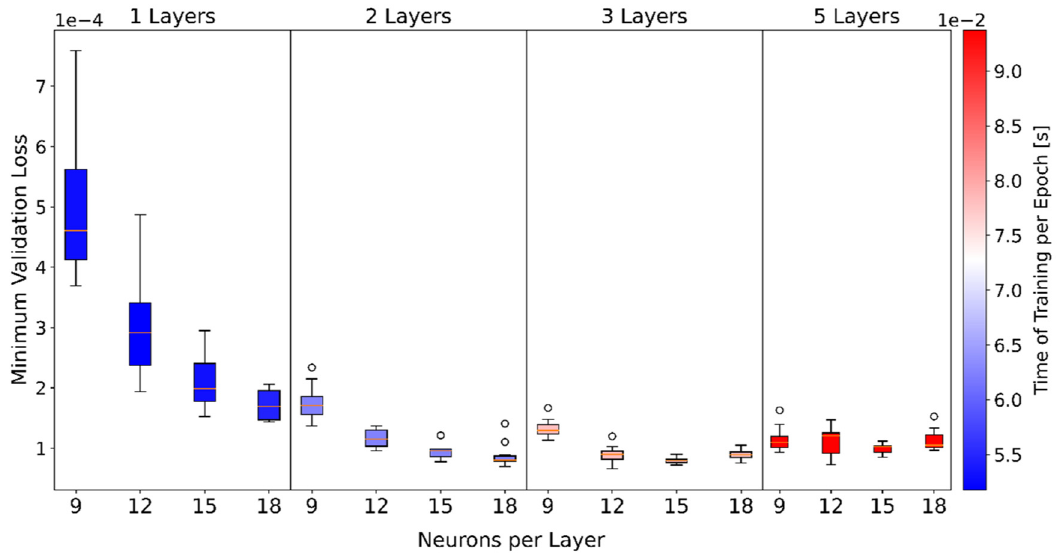
Figure 6. Boxplot of minimum Validation Loss and mean training time per epoch for each architecture.